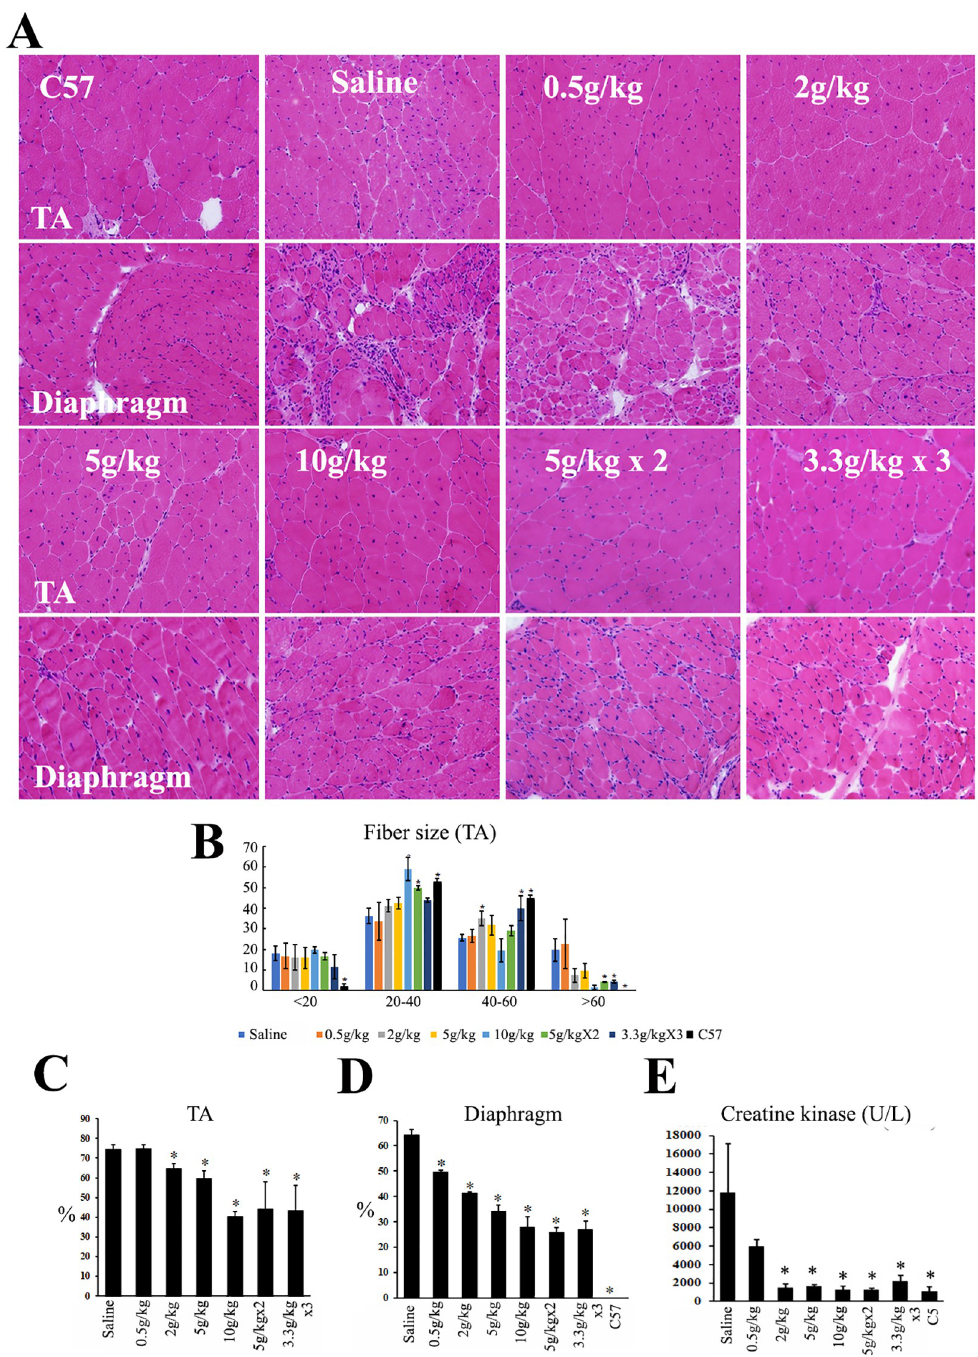
Fig 2. Dose-dependent improvement in muscle pathology of P448L mutant mice after ribitol treatment. (A) H&E staining of skeletal muscles, Tibialis anterior (TA) and diaphragm. (B) Fiber size ( μ M in diameter) distribution as a percent of the total fibers. n = 5. (C) and (D) Percentage of centrally nucleated fibers in TA and diaphragm. n = 5. (E) Serum levels of creatine kinase. n = 10. � P < 0 . 05 when compared with saline-treated control.